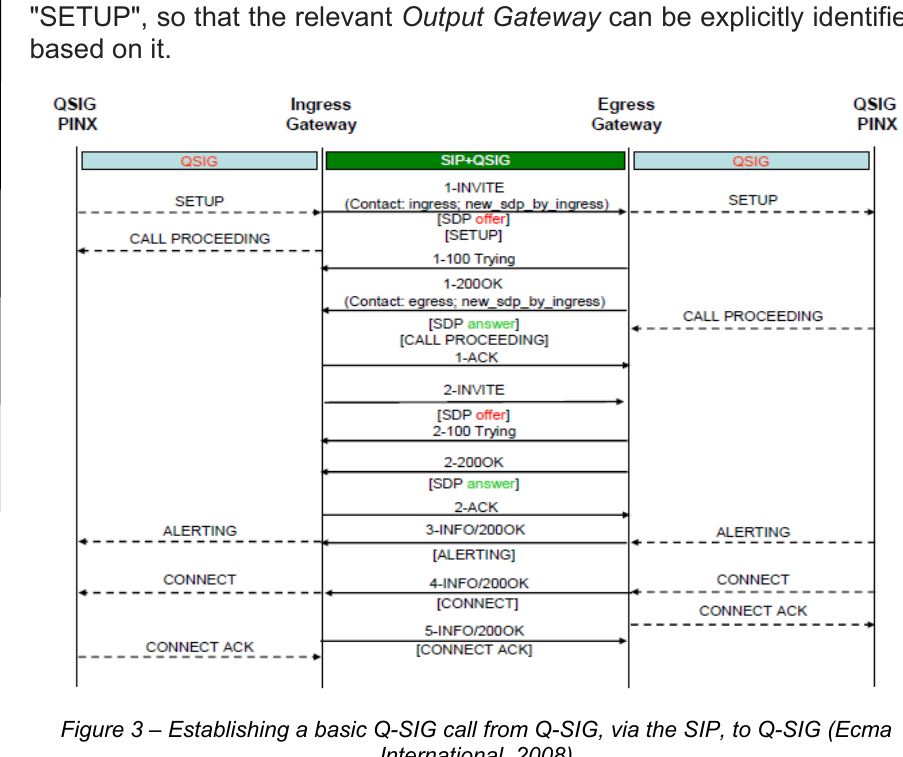
Figure 3 – Establishing a basic Q-SIG call from Q-SIG, via the SIP, to Q-SIG